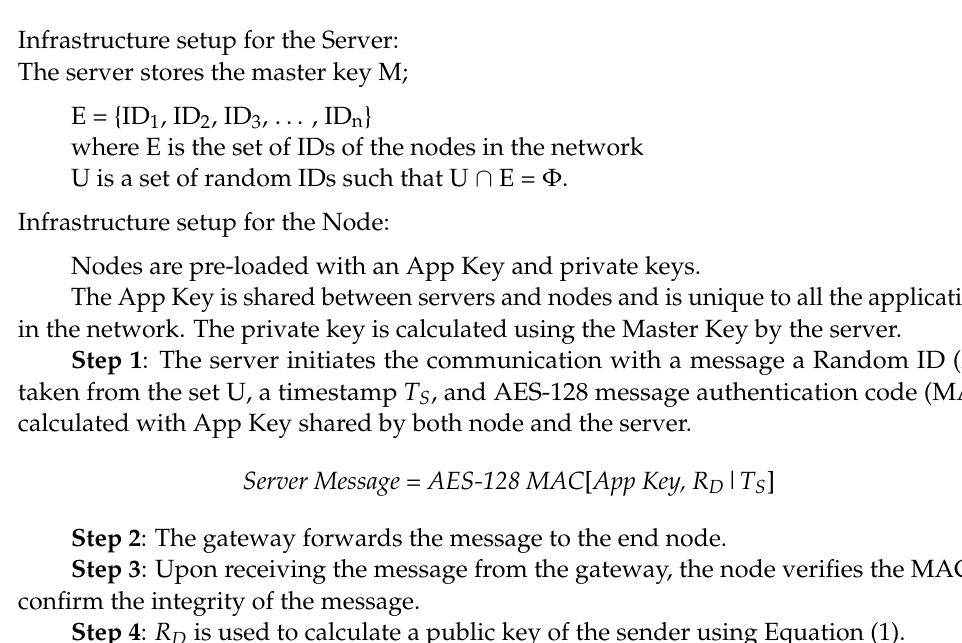
Figure 3. Sequence Diagram for the Session Key Generation.